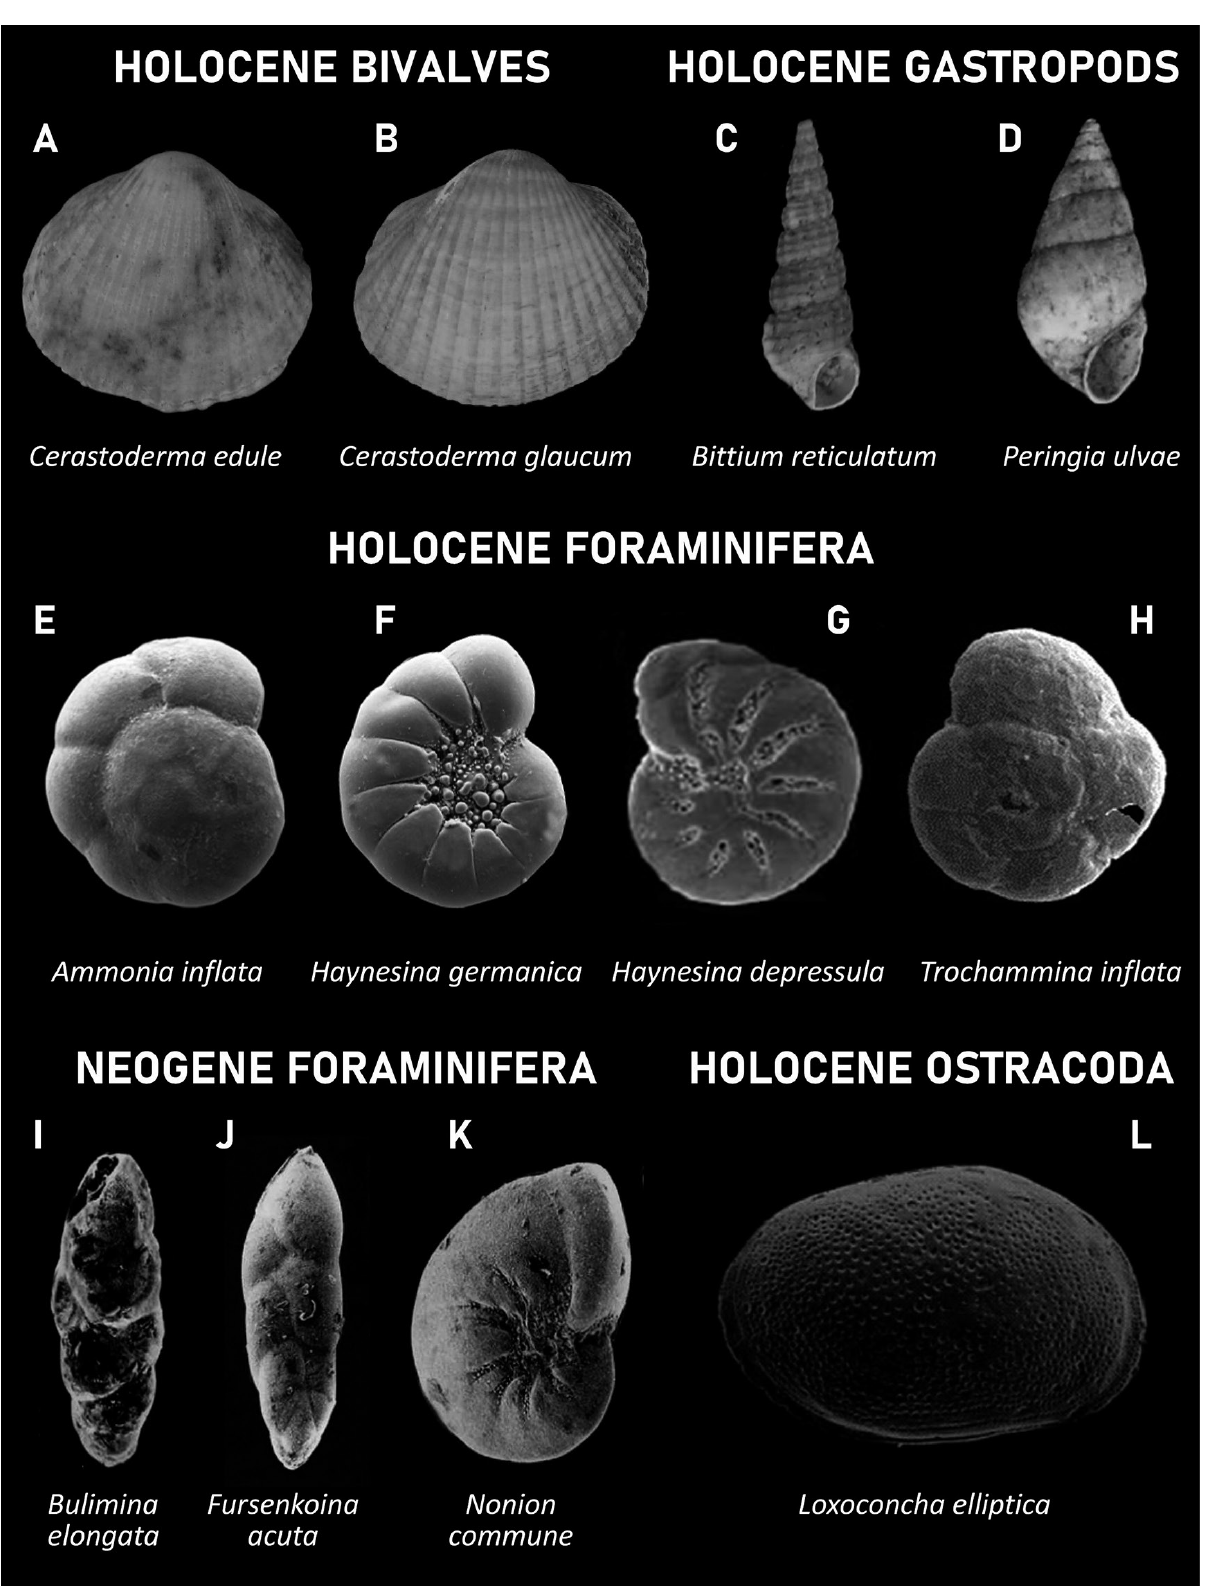
Fig. 5. – Main species of core B. Scale not